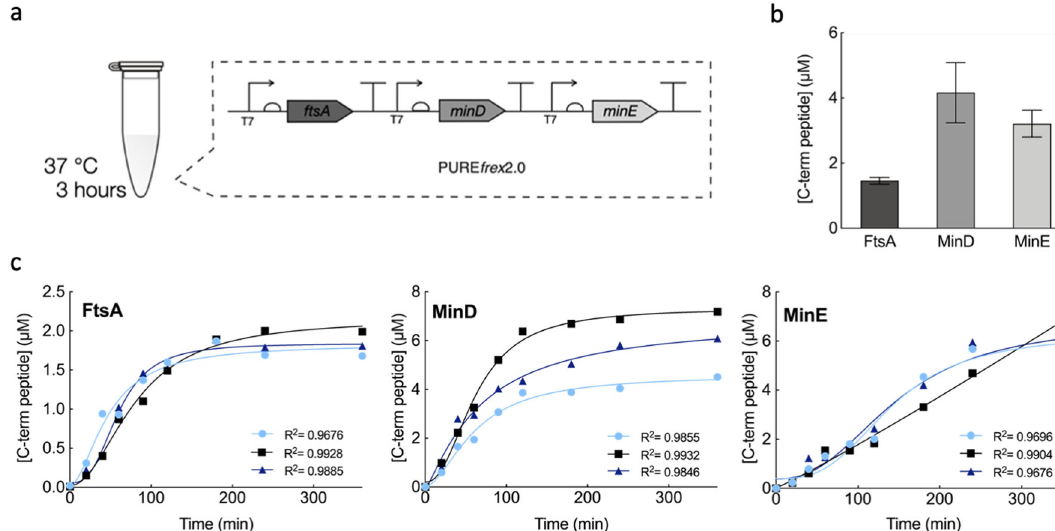
Fig. 1 Quanti fi cation of cell-free expressed FtsA, MinD and MinE proteins from a single DNA construct. a Each gene, ftsA , minD and minE , was placed under its own T7 promoter, ribosome binding site and T7 transcription terminator and was constitutively expressed with PURE frex 2.0 in test-tube reactions. b Quantitative LC-MS analysis of FtsA, MinD and MinE protein production after 3 h of expression at 37 °C. Abundance of the most C-terminal proteolytic peptide was quanti fi ed for each protein using an internal standard (QconCAT). Data represent mean values over three biological repeats, each analyzed in three technical replicates. c Concentration of FtsA, MinD and MinE (most C-terminal peptide) as a function of the expression time course (from 0 to 6 h). Symbols represent data from three independent experiments. The solid lines are fi ts to a mathematical model for gene expression kinetics (Methods